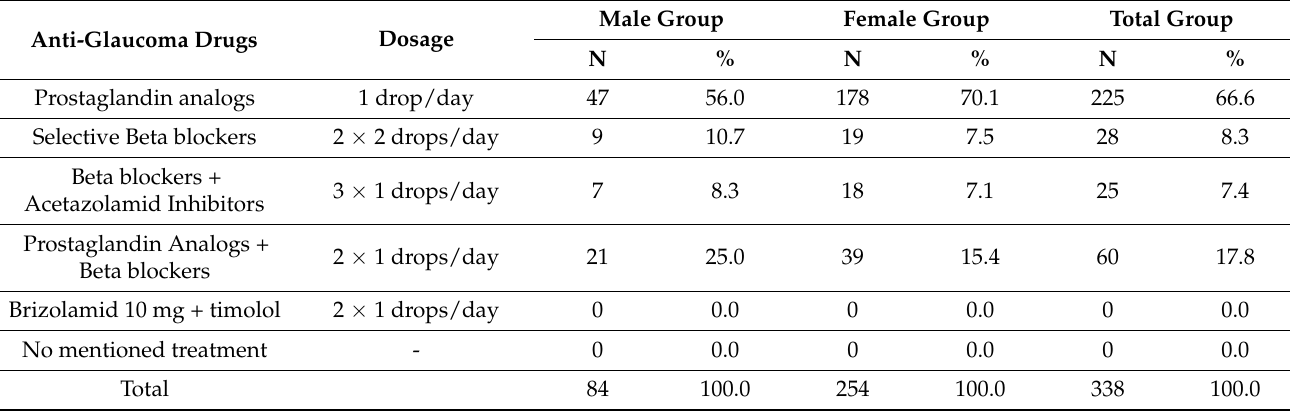
Table 15. Distribution of recommended drug classes and their dosage in the treatment of patients with calculated NTG. Anti-Glaucoma